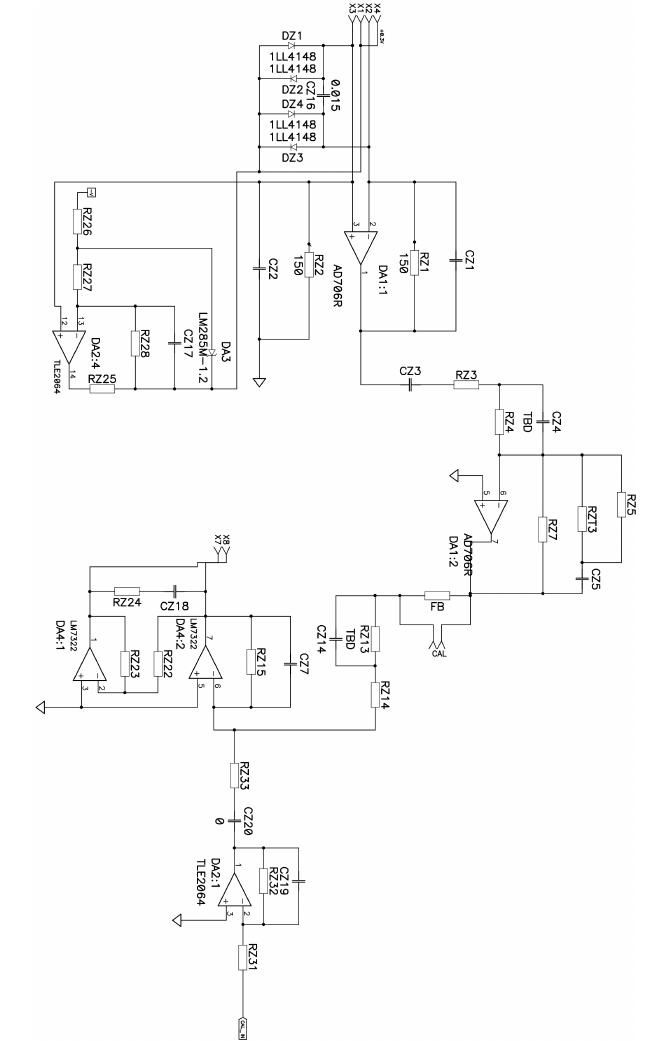
Figure 4. The MET hydrophone electronic